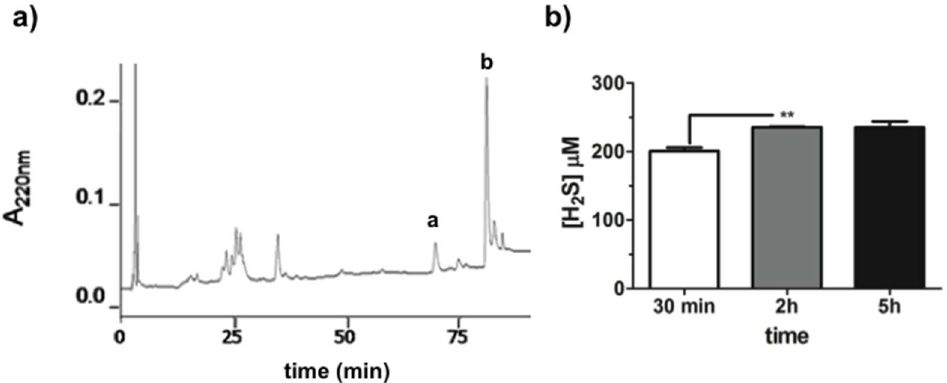
Figure 1. Characterization of the GaOS extract. ( a ) RP-HPLC chromatogram of the GaOS obtained using C 18 column at 0.8 mL/min flow rate. The elution was performed with a linear gradient of solv. B (80% CH 3 CN, 0.1% TFA). Peaks a and b are characteristic of DADS; ( b ) H 2 S-release by 25 μL of GaOS after 30 min, 2 h and 5 h of incubation at 37 °C in the presence of 1 mM DTT and detected by MB assay. ** p < 0.02